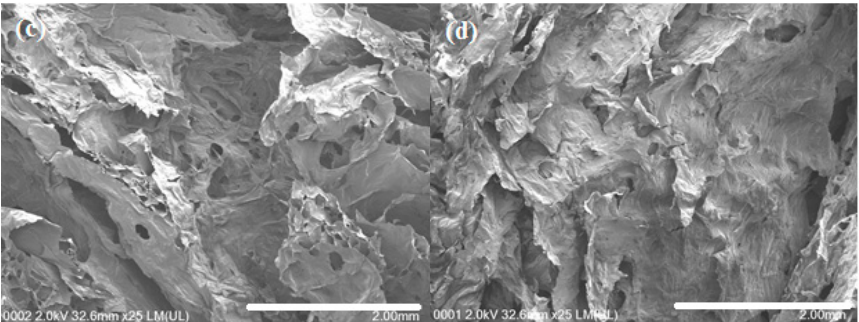
Figure 3. FESEM images for the cross section of: ( a ) gas foamed hydrogel; ( b ) hydrogel formed at atmospheric condition; ( c ) gas foamed hydrogel after immersed in SGF; and ( d ) hydrogel formed at atmospheric condition after immersed in SGF.